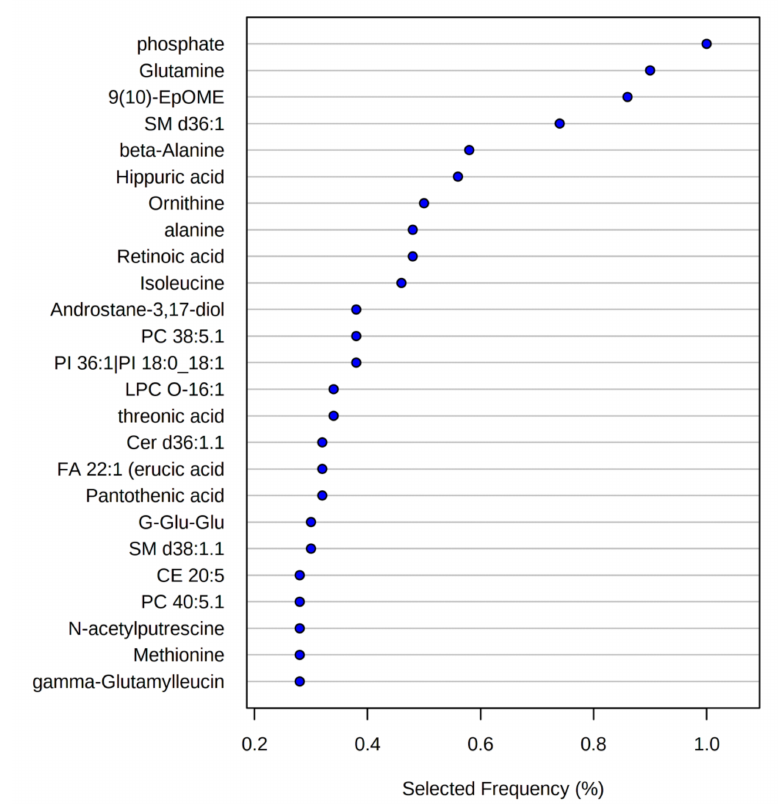
Figure 9. Variable importance from the SVM model with 25 metabolites. Metabolites are ranked from most to least important. The colored boxes on the right indicate metabolite concentrations in each patient group. SM, sphingomyelin; PC, phosphatidylcholine; PI, phosphatidylinositol; CE, cholesteryl ester; TG, triacylglycerol; 9,10-EpOME, 9,10-epoxyoctadecenoic acid; LPC, lysophosphatidylcholine; FA, fatty acid; Cer, ceramide; G-Glu-Glu, gamma-glutamyl-glutamic acid.